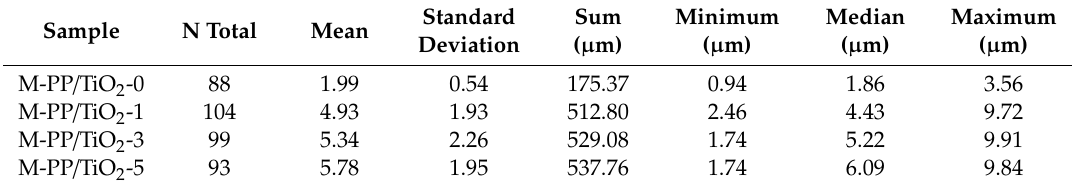
Figure 4a–c. The XRD pattern of M-PP / TiO 2 -0 predominantly consists of α -phase with (110), (040), and (130) characteristic peaks at 2 θ = 14 (004), and (200) characteristic peaks corresponding to 25.37